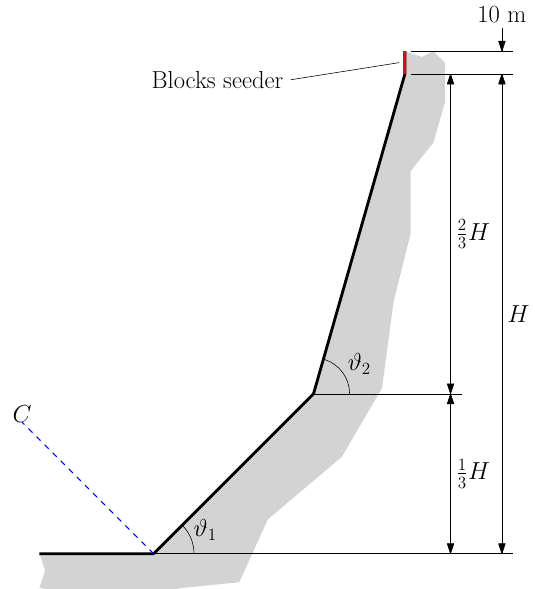
Figure 1. Sketch of the synthetic double slope profile adopted for the